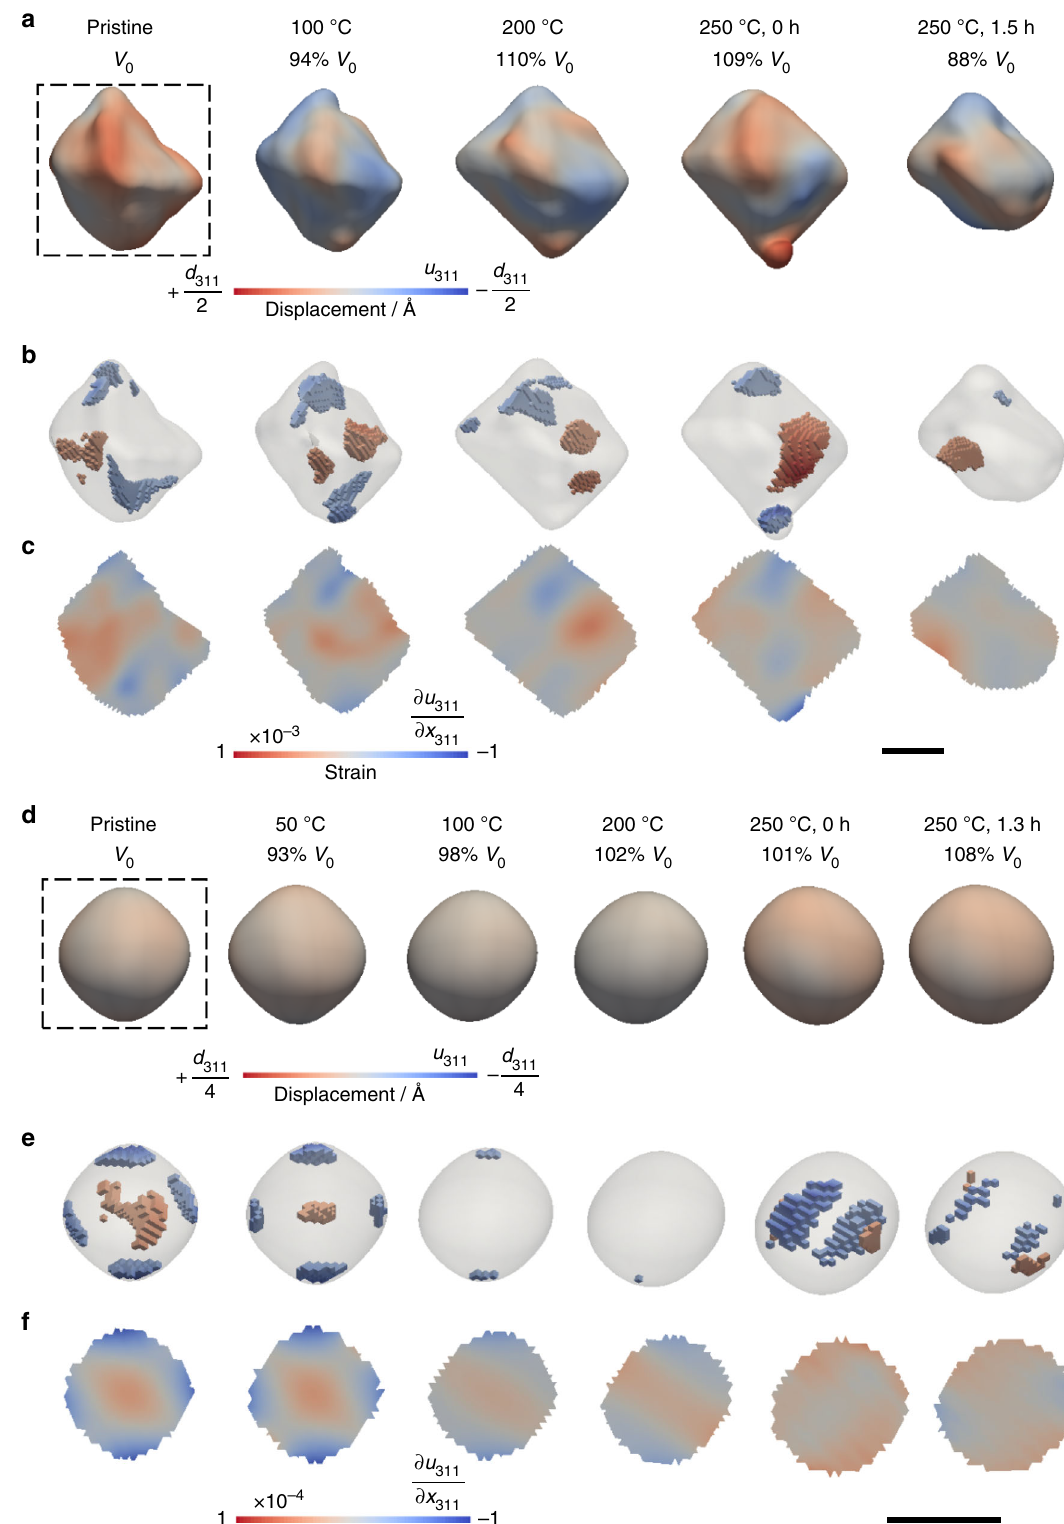
Fig. 5 In situ heating of two magnetite crystals from room temperature to 250 °C in air. a , d 3D volume views at a 30% amplitude threshold with lattice displacement along the [311] direction projected on the isosurfaces. b , e 3D strain structure of compressive (blue, strain < − 0.00035/ − 0.000035) and tensile (red, strain > 0.00035/0.000035) strains. c , f Cross-sectional views of the internal strain fi eld at the dashed line box in a and d , respectively. Scale bar, 200